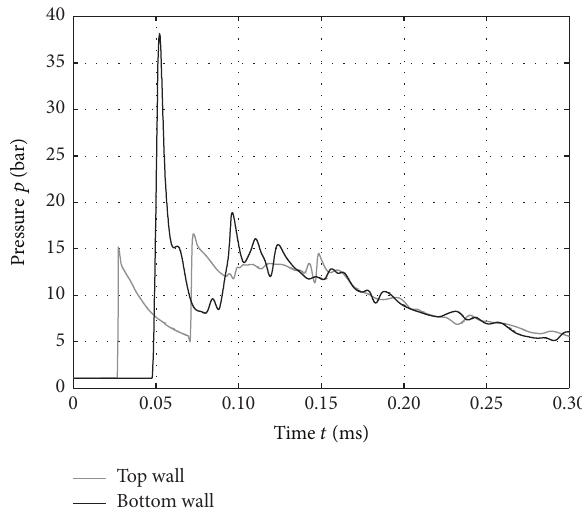
Figure 15: Pressure records from a steadily propagating detonation in a mixture with 25% H 2 (max. concentration gradient).